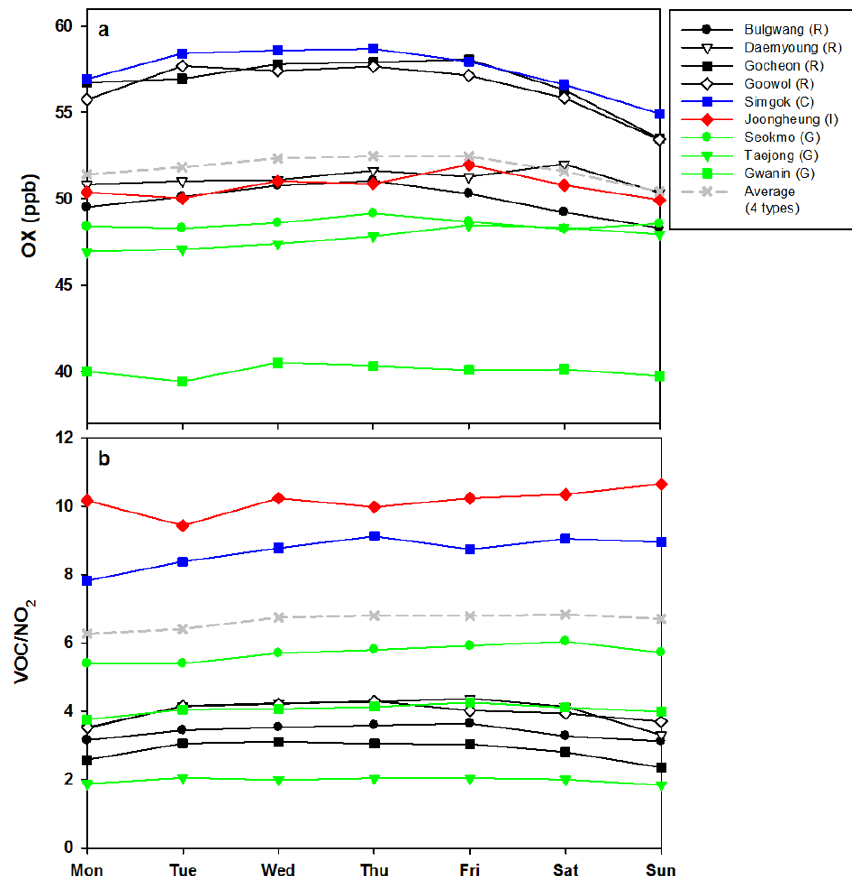
Figure 12. Weekly variations in the (a) OX and (b) VOCs / NO 2 values 2007 at nine of the photochemical air pollution monitoring stations of the MEK in South Korea. Please see Table 2 for the observational period at each of the VOC